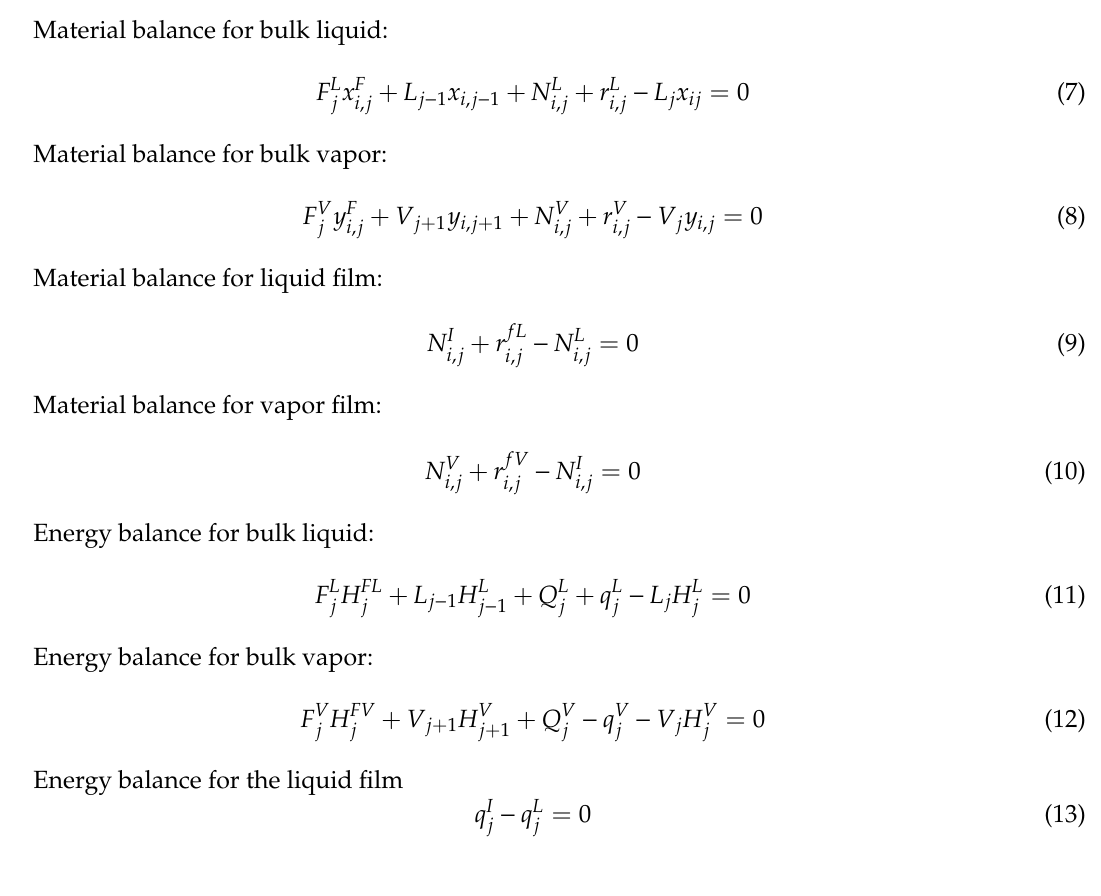
Figure 4. Rate-based stage model (Reproduced from ASPEN PLUS software manual).